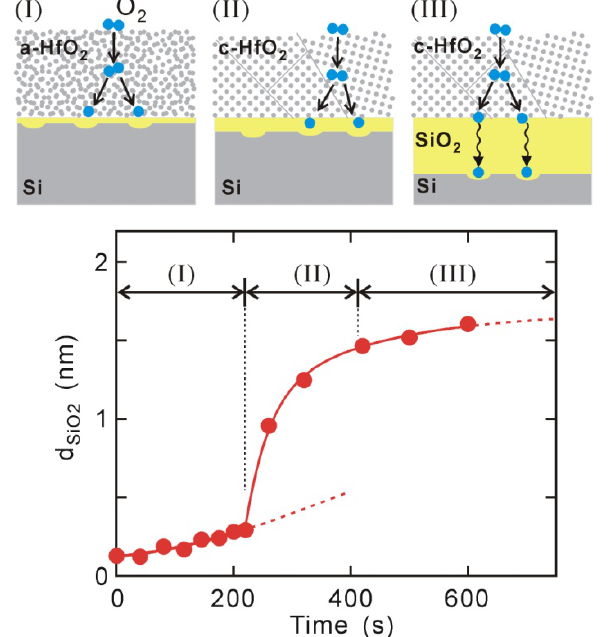
Figure 2. Si oxidation at 1.5-nm HfO torr at 400–500 °C. Oxidation occurred in three steps of ( I ) slow oxidation in range of monolayer Si oxide; ( II ) rapid oxidation up to thick SiO ( III ) slow oxidation demonstrating saturated behavior. Oxidation mechanisms expected for stages (I)–(III) have been